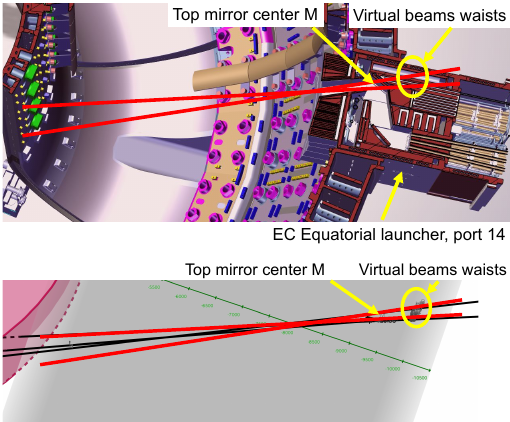
Fig. 1 . Launching scheme from the top mirror of port equatorial 14: above, cross section of launcher and vacuum vessel; below, geometrical representation of the